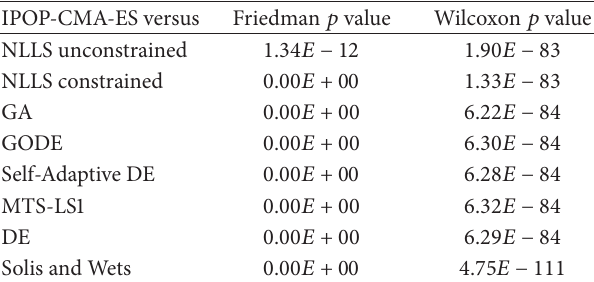
Table 12: Raw 𝑝 values (IPOP-CMA-ES is the control algorithm) for the 8-term Gauss series.